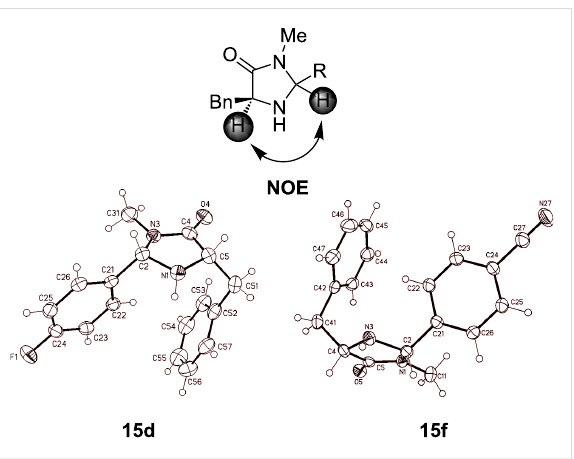
Figure 5: Confirmation of the relative configuration with NOESY exper- iments and X-ray crystal structures of two imidazolidinones 15d and 15f